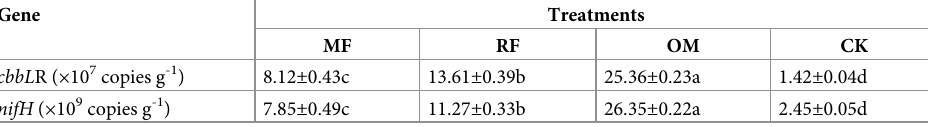
Different lowercase letters in the same line were indicated significantly difference at p < 0.05 level.